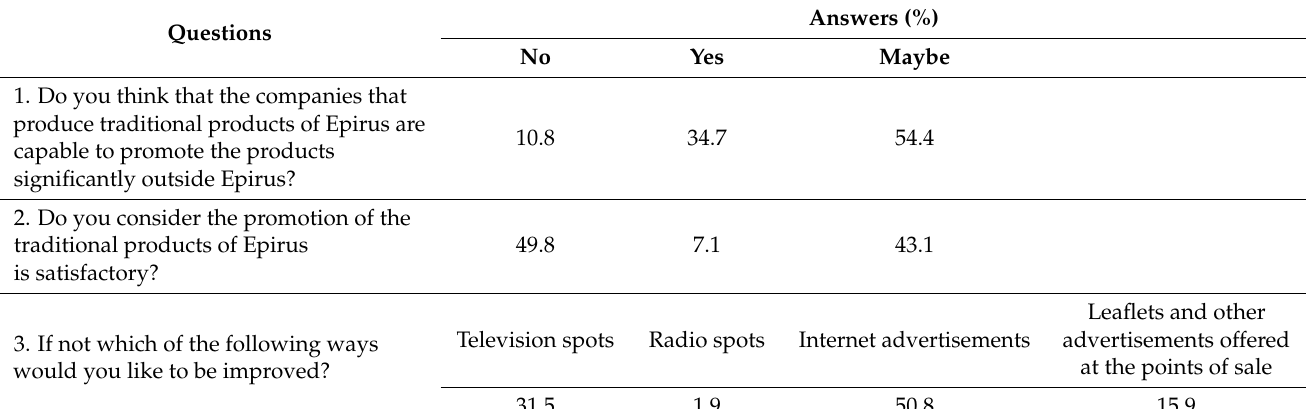
Table 5. Participants’ perception for the marketing of Epirus’